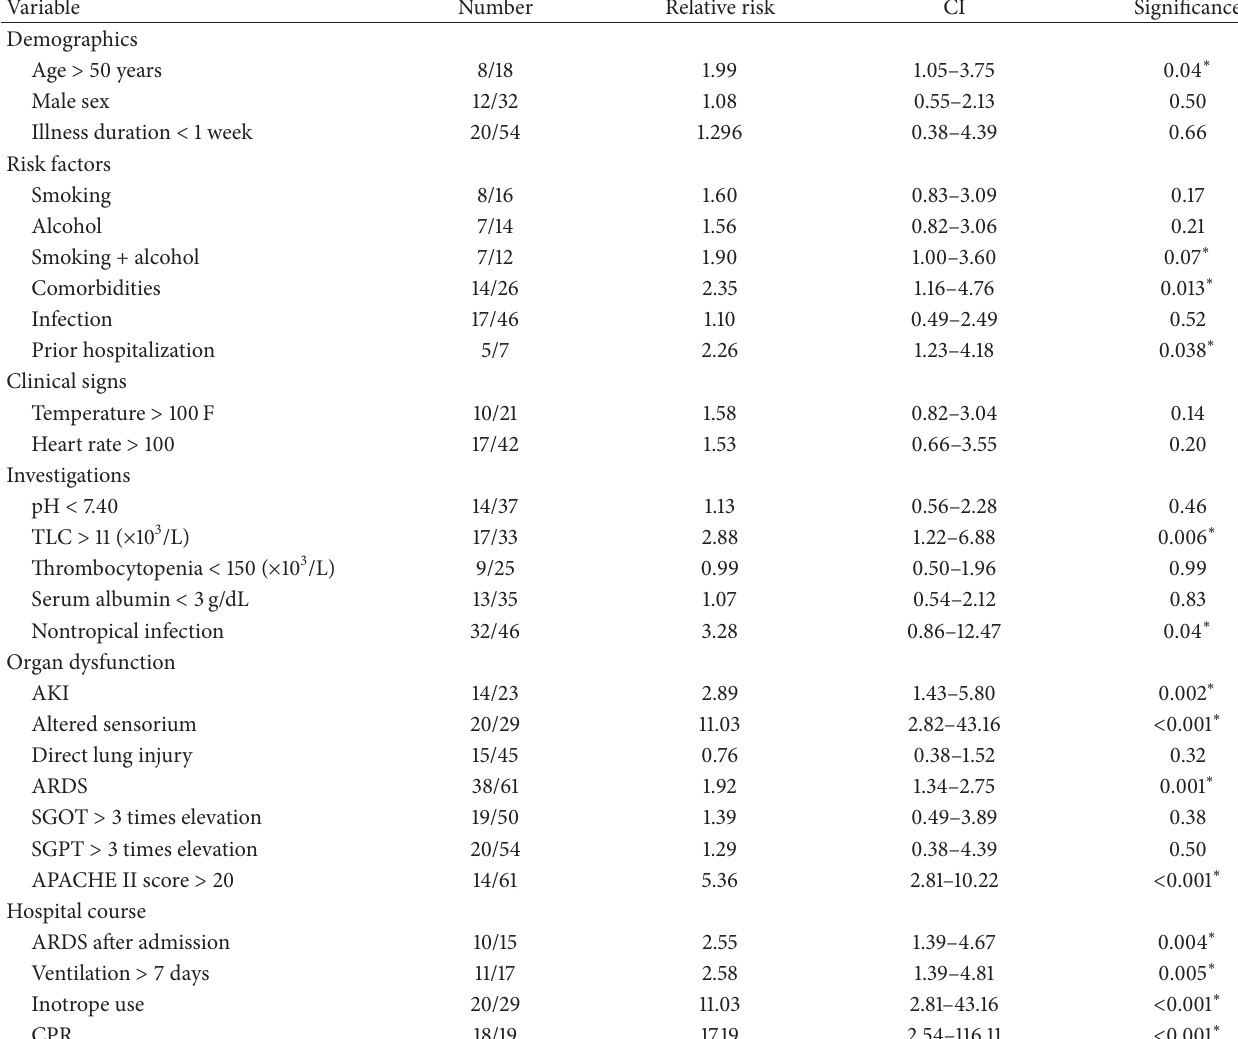
Table 3: Univariate analysis of risk factors for